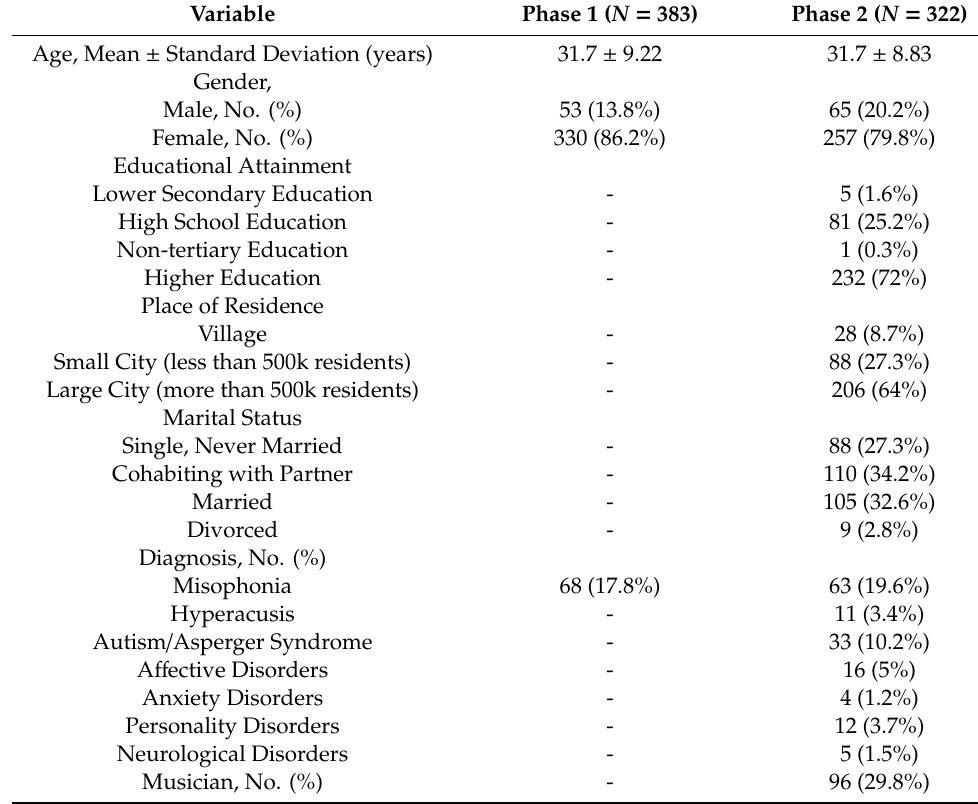
Table 2. Demographic characteristics of the studied